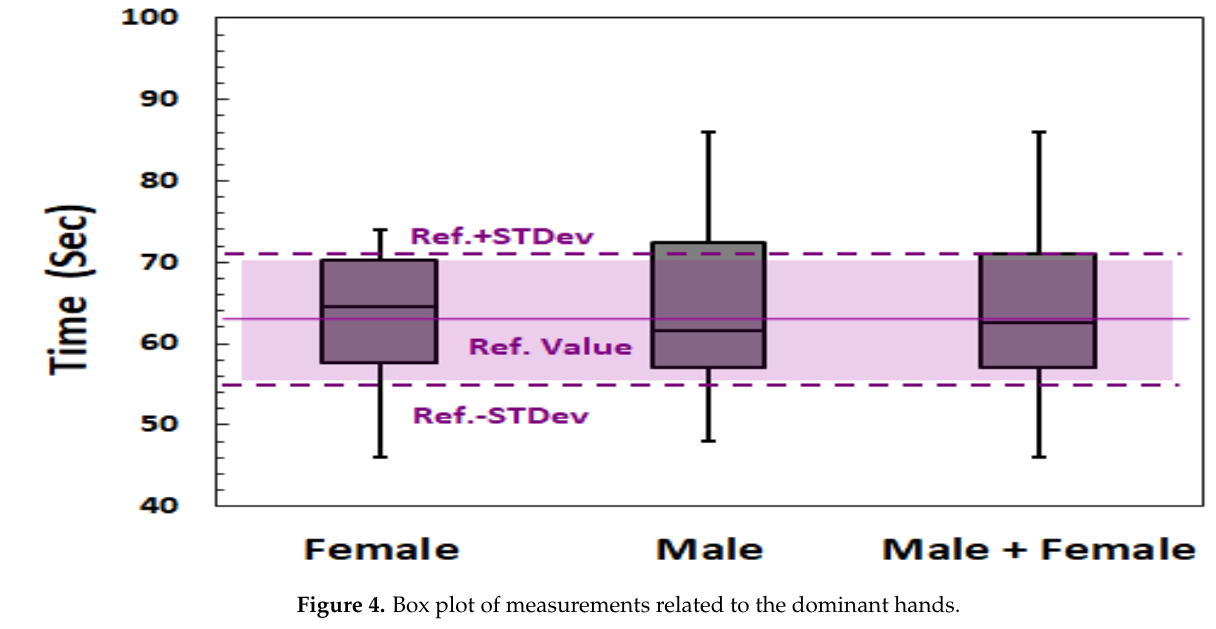
Figure 4. Box plot of measurements related to the dominant hands.